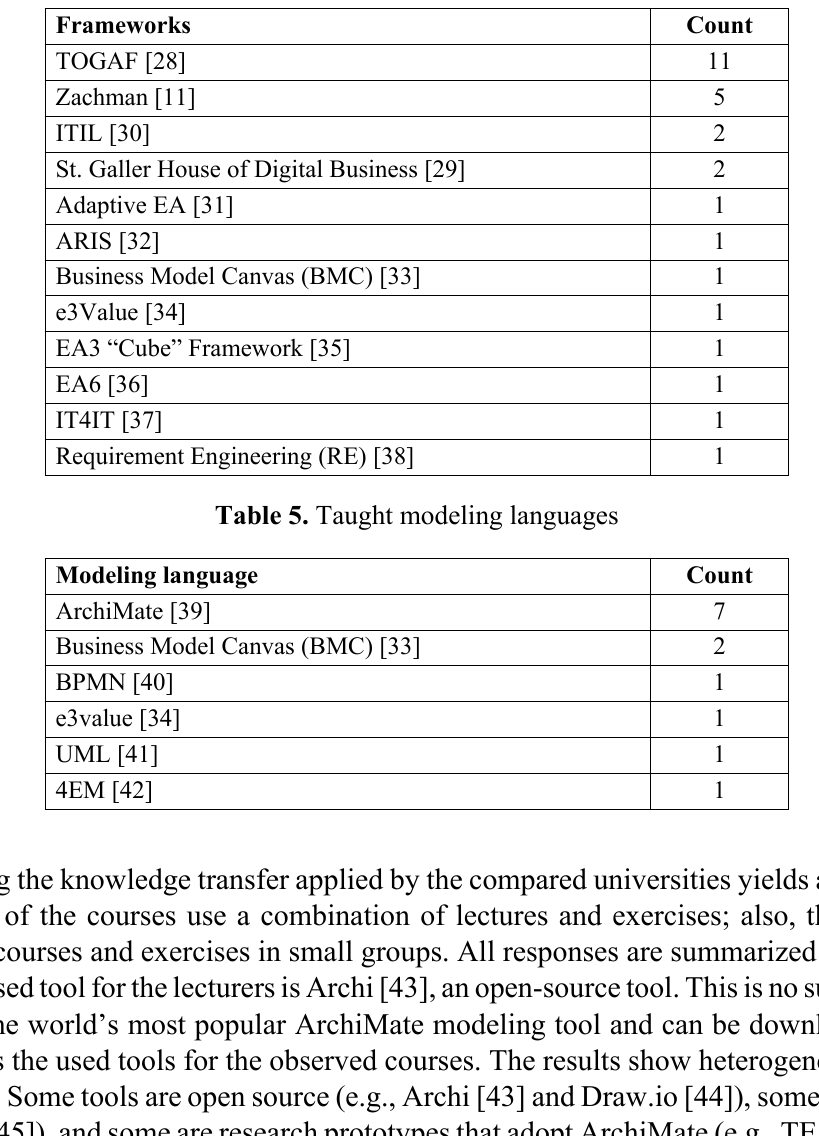
Figure 7. Teaching languages Table 4. Taught frameworks